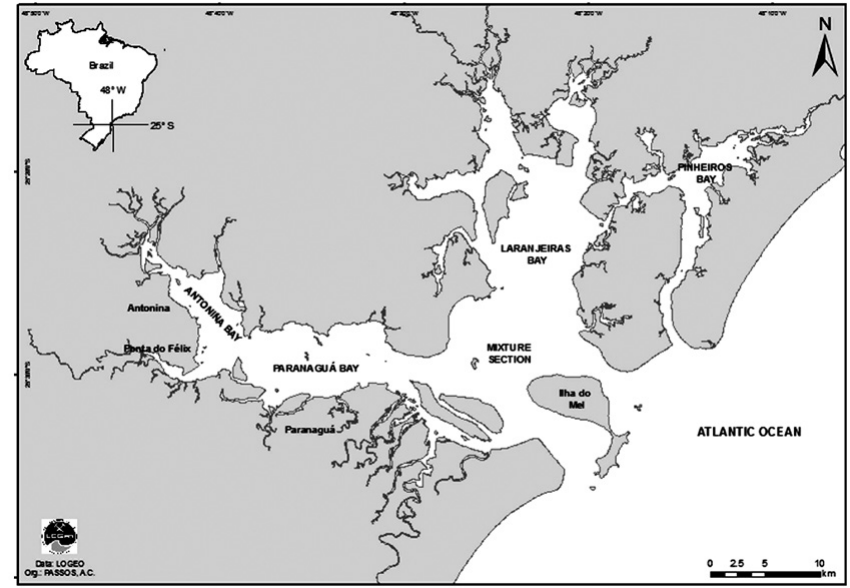
Fig. 1. – Map of the Paranaguá Estuarine Complex (Paraná State, Brazil). Source: Passos et al.